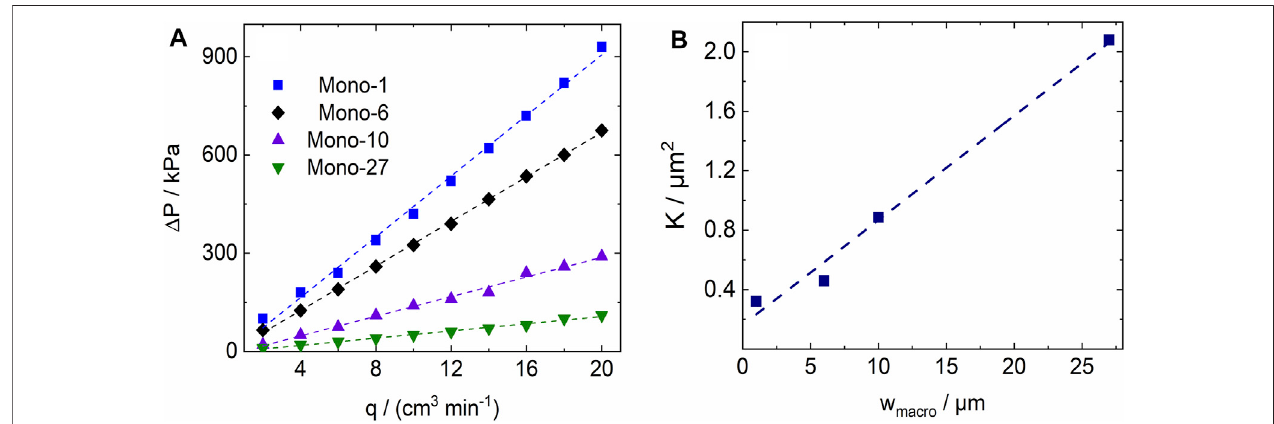
FIGURE 4 | (A) Pressure drop relative to the applied volumetric fl ow rate of water across the glass-cladded HSM samples (Mono-1 to Mono-27) of L (cid:2) 2 cm, D (cid:2) 0.5 cm, and A (cid:2) 0.196 cm 2 at T (cid:2) 298 K. (B) The calculated permeabilities as a function of the mean macropore width of the HSM.